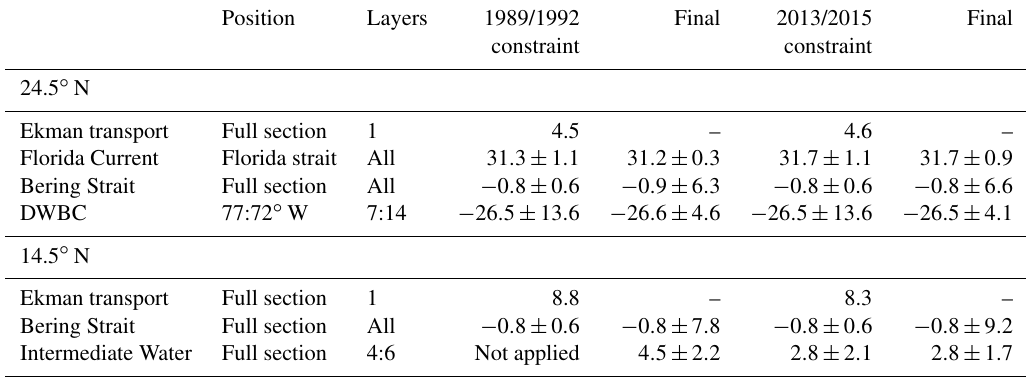
Table 2. Constraints for the box inverse model and the final adjusted transport after inversion. Note that the box inverse model does not adjust the meridional Ekman transport, which is prescribed using the annual zonal wind stress during the calendar year of the cruise. The unit of the transport is sverdrups. Southward transport is given with